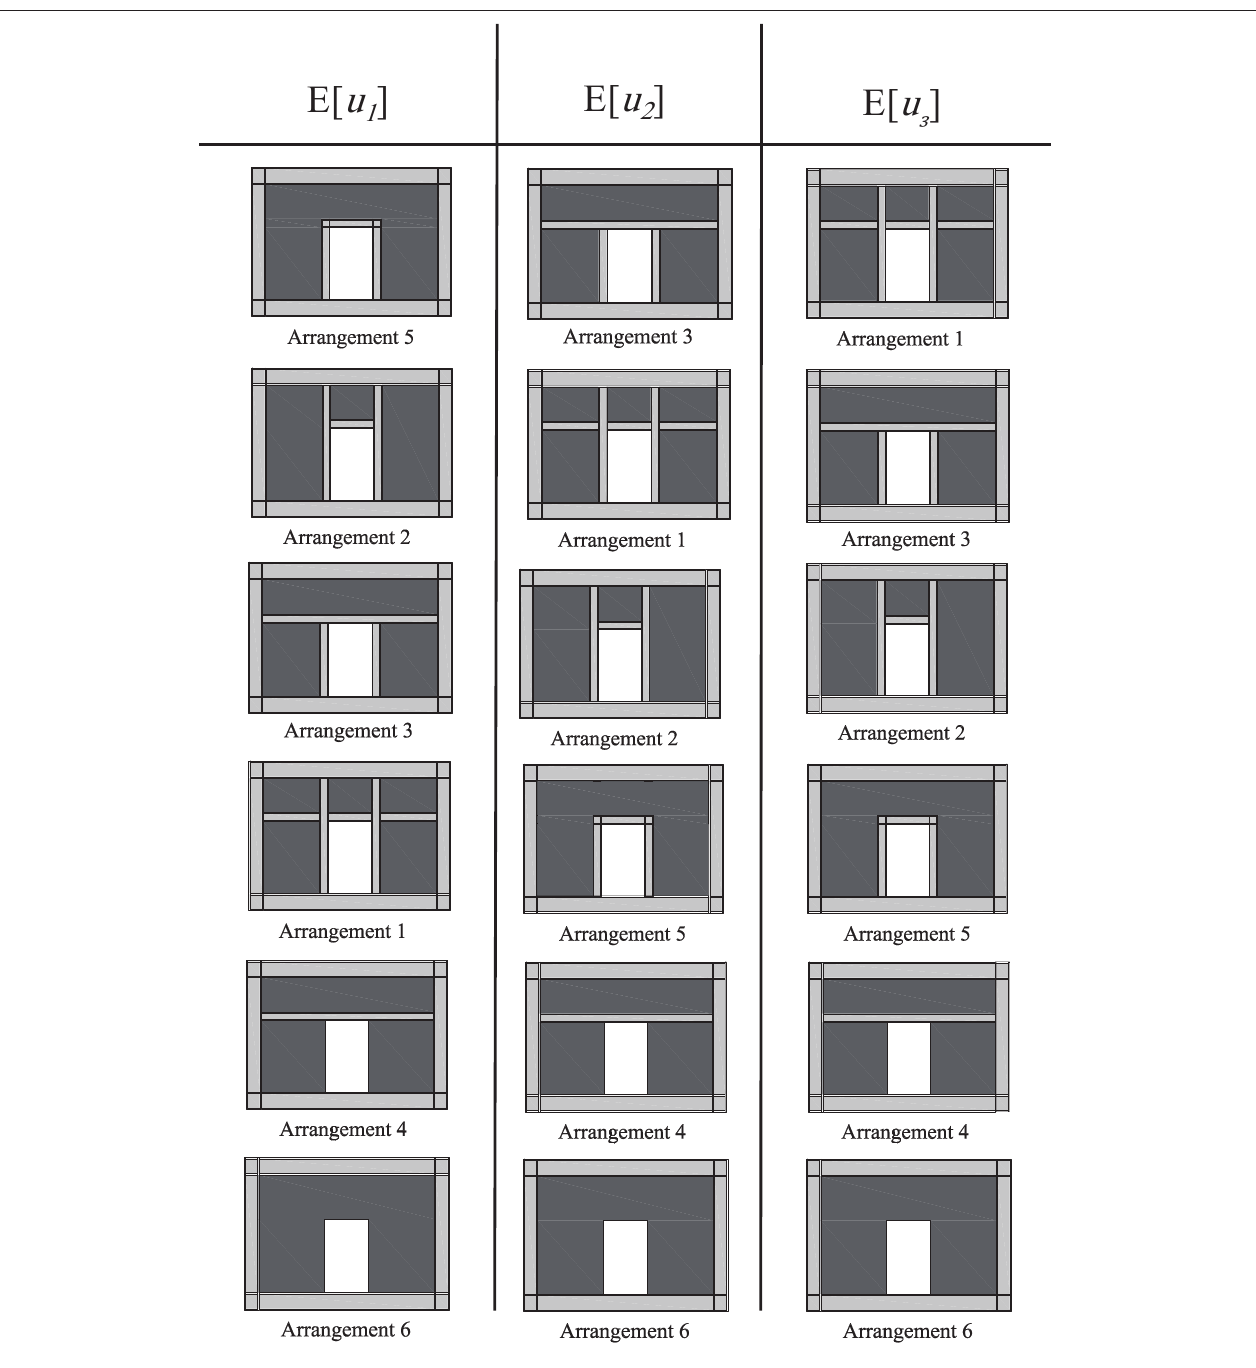
FIGURE 11 | Ranking the models based on expected utility in descending order.